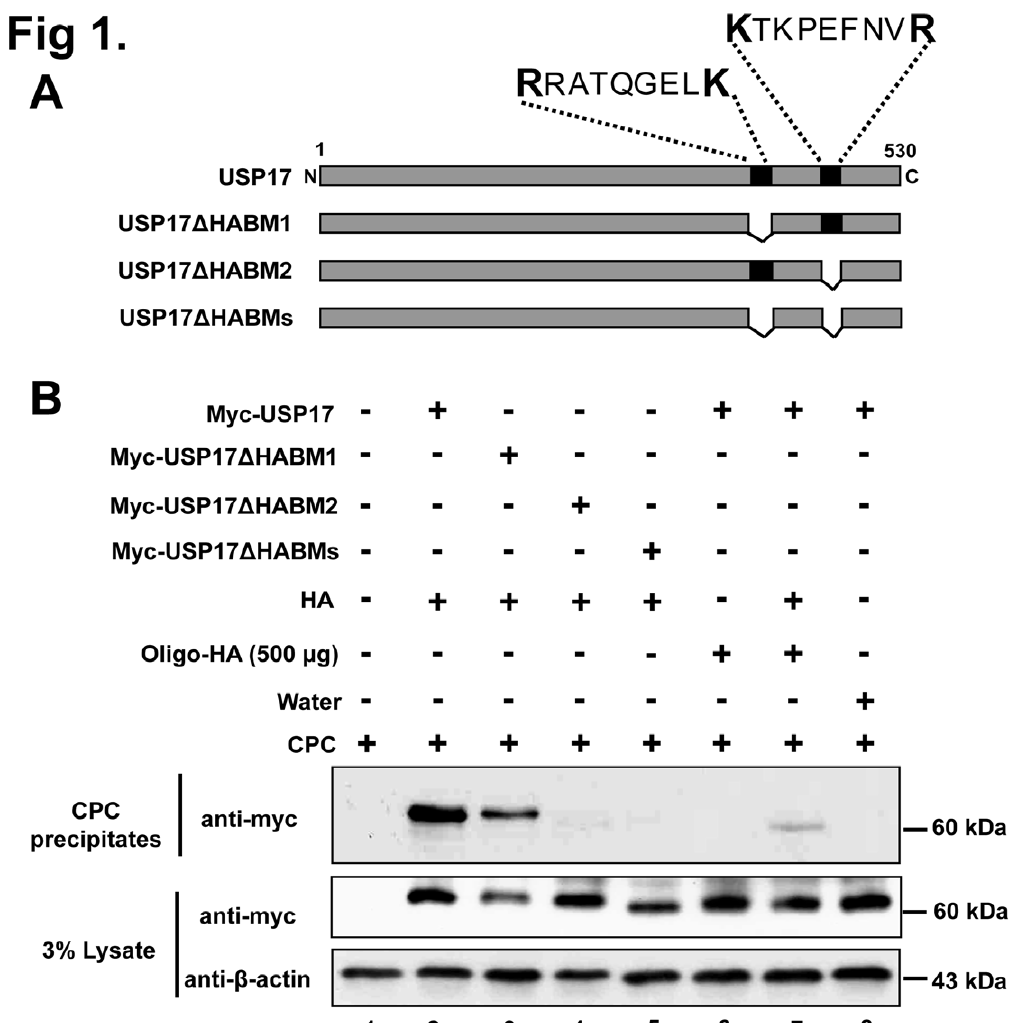
Figure 1. Hyaluronan-binding activity of USP17. A ) Schematic representation of HABM-deleted constructs of USP17. B ) HA binding to HABM- deleted constructs of USP17. Cell lysate aliquots from 293 T cells transfected with different USP17 deletion constructs were incubated with HA and HA oligosaccharides and subjected to CPC precipitation. Western blot analysis was performed using an anti-myc antibody. The lower panel contains an aliquot of whole cell lysate without addition of CPC or HA. C ) Binding of USP17 to HA oligosaccharides. Cell lysate aliquots from 293 T cells transfected with USP17 were incubated with different concentration of HA oligosaccharides and subjected to CPC precipitation followed by Western blot analysis with an anti-myc antibody. D ) Cell lysate aliquots from 293 T cells transfected with USP17 and HABMs-deleted USP17 were incubated with high concentration of HA oligosaccharides (2000 m g) and performed CPC precipitation followed by Western blot analysis. E ) Cell lysate aliquots from 293 T cells transfected with USP17 were incubated with 20 m g of each USP17 peptide or together in the presence of HA and performed CPC precipitation followed by Western blot analysis.